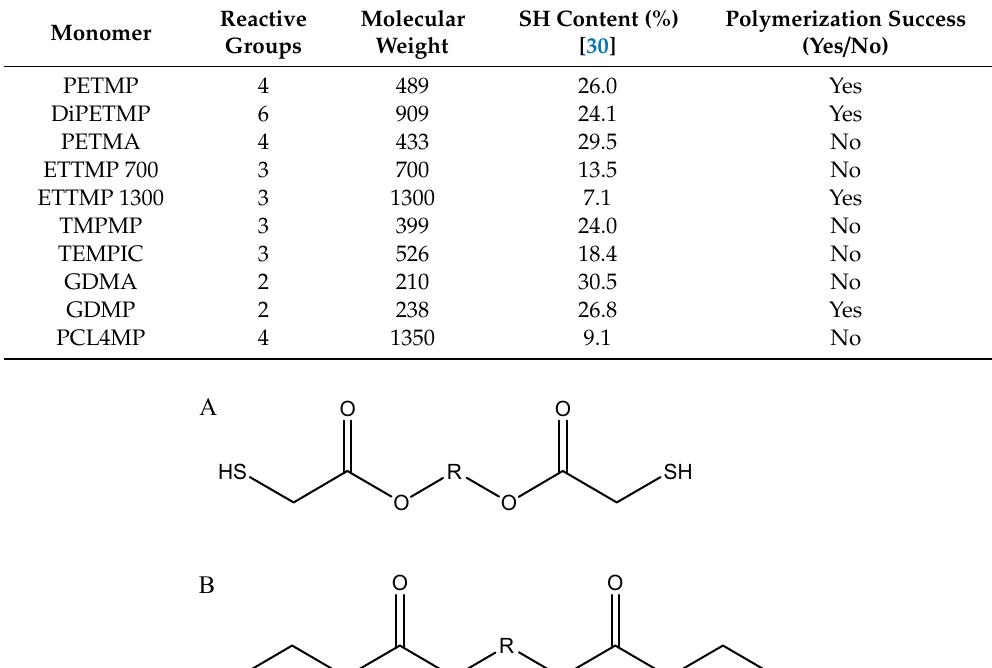
Table 2. Results of the PEGDMA-thiol polymerisation check.